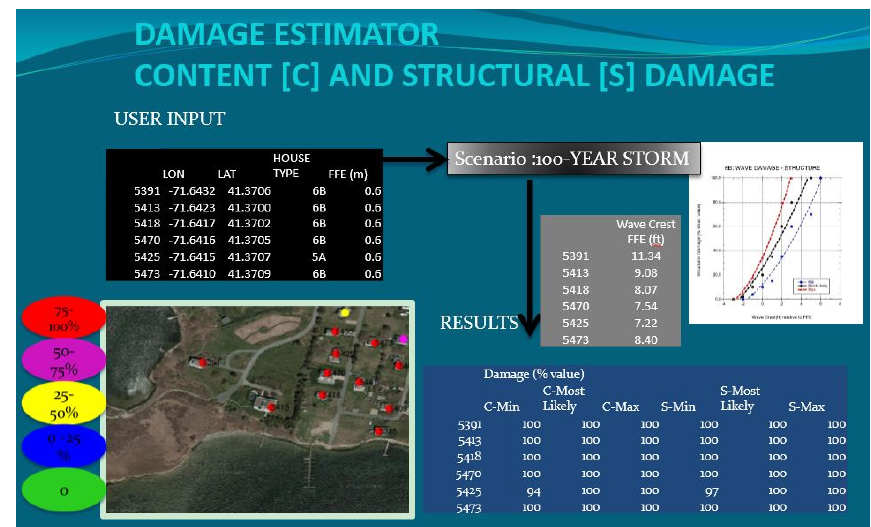
Figure 20. Input on structure (number, location (latitude/longitude), prototype, and FFE), total water level (relative to FFE), and structure and content damage (minimum, most likely, and maximum) by structure.